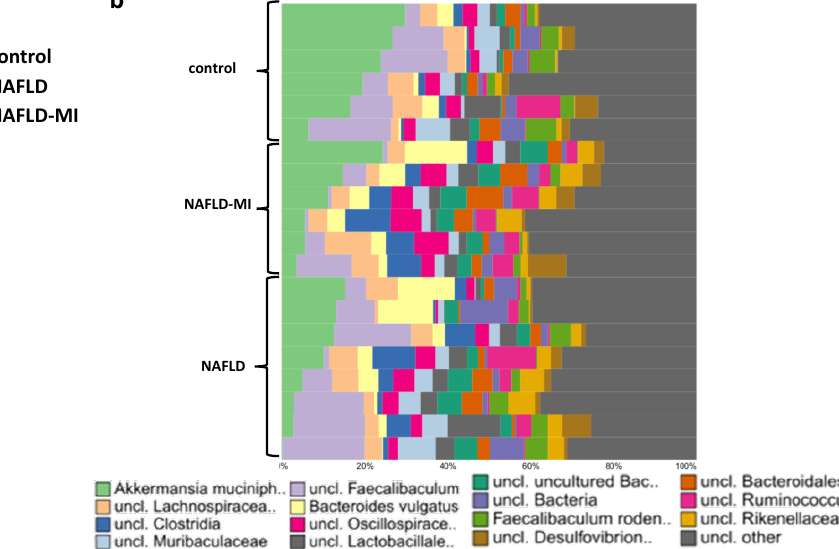
Figure 4. ( a ) Estimation of bacterial diversity as assessed by the Shannon index. ( b ) Overview of microbial composition at genus level in the control, NAFLD, and NAFLD-MI groups. # p < 0.05 vs. NAFLD mice. Table 1. Differences in genus abundance between the different animal groups.